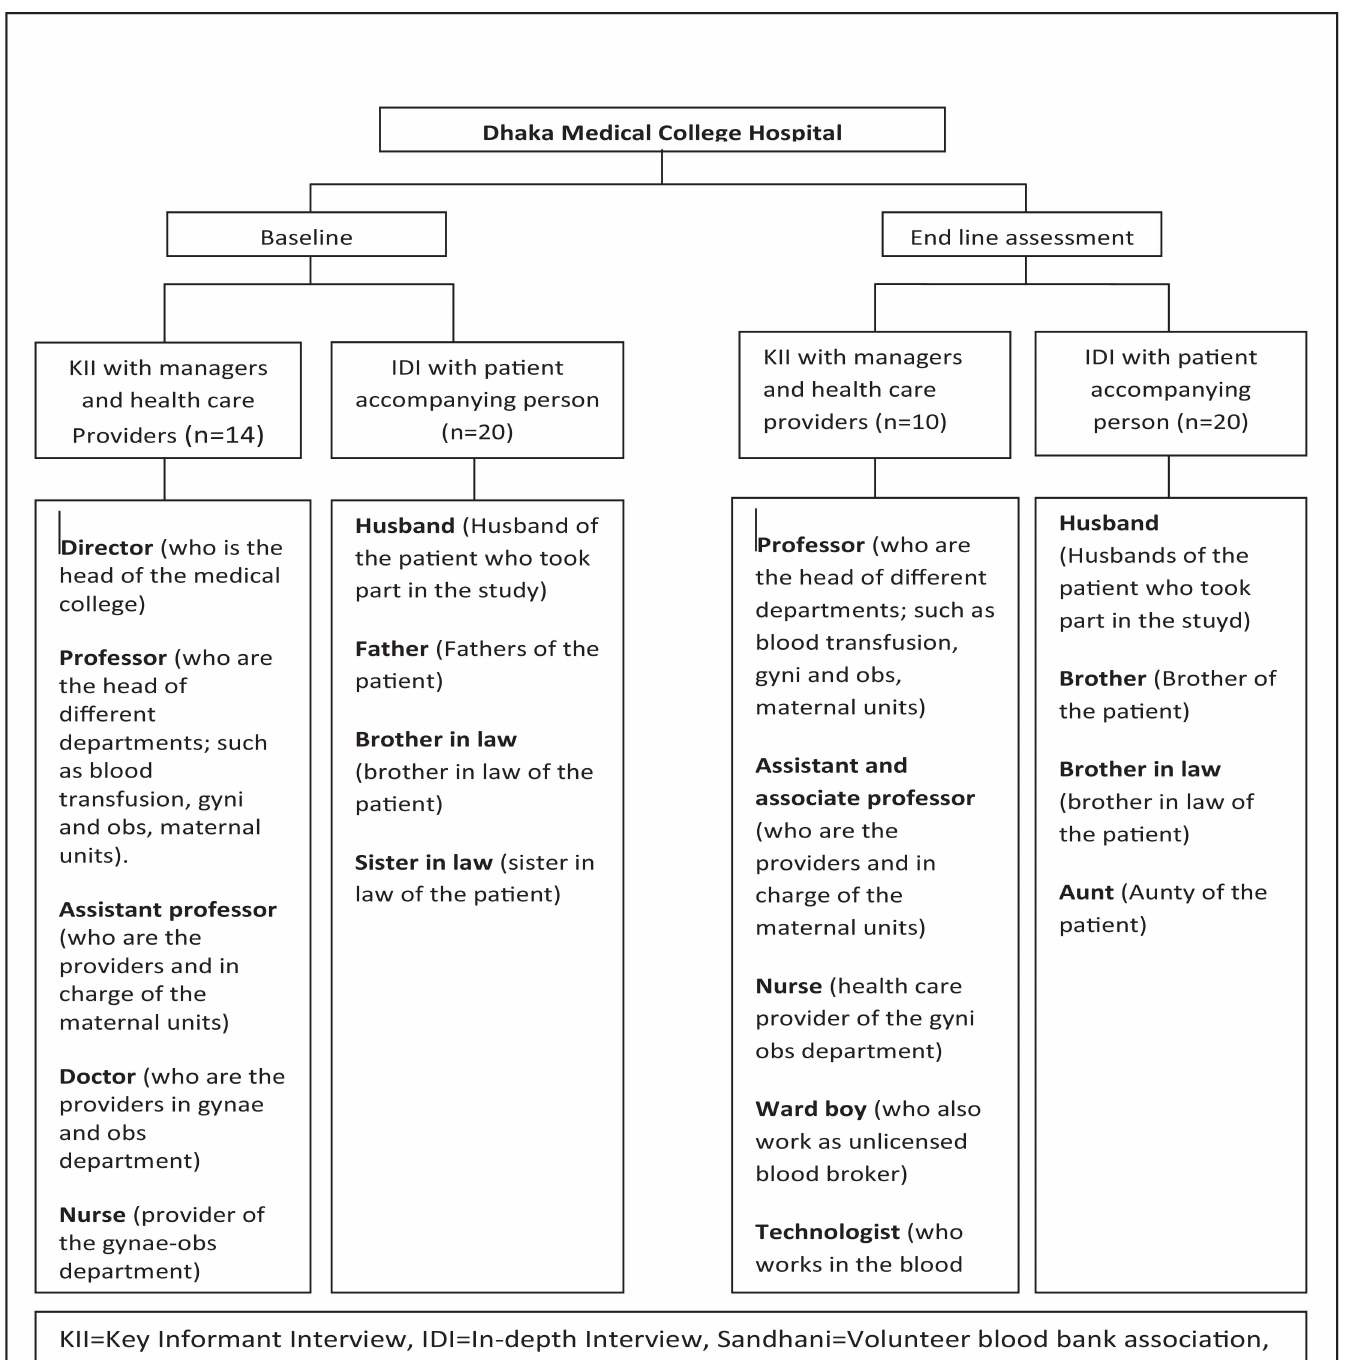
Fig 1. Detail sampling frame